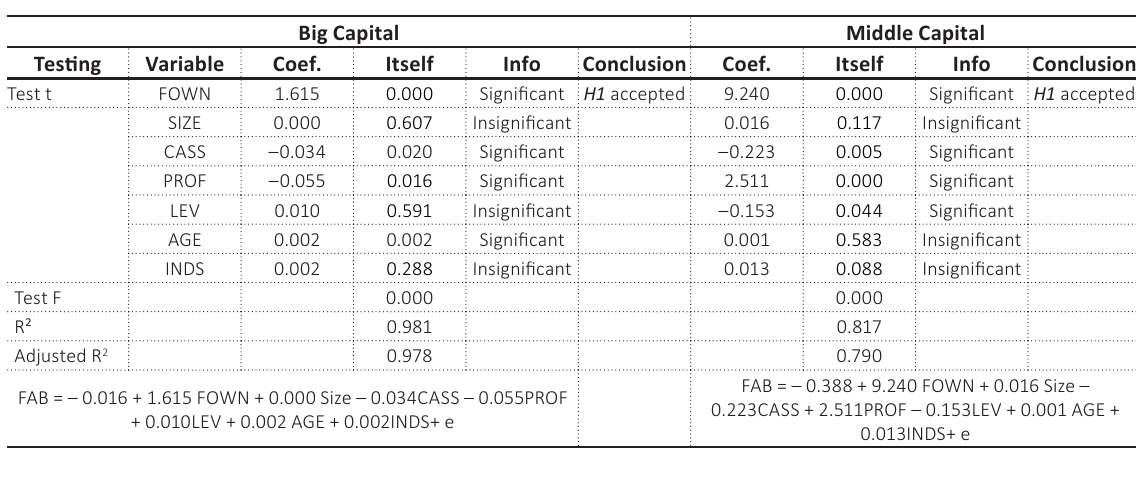
Table 5. Regression analysis results ( H1 )